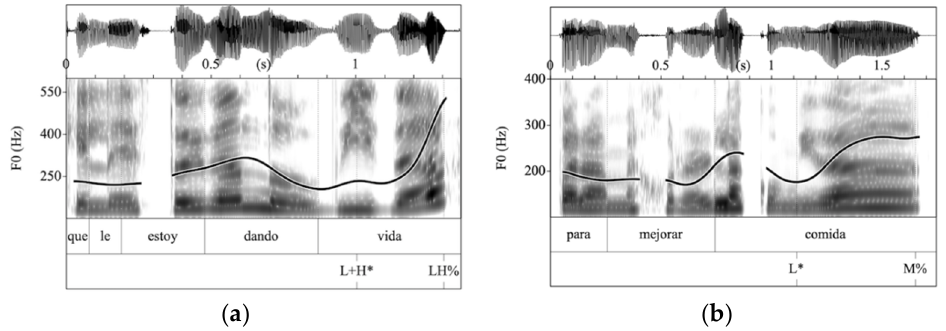
Figure 6. ( a ) Example of the L+H* LH% nuclear configuration (i.e., complex contour) of a monolin- gual speaker. que le estoy dando vida ‘to whom I am giving life’; ( b ) Example of the L* M% nuclear configuration (i.e., simple contour) of a heritage speaker. para mejorar la comida ‘to improve the food’).